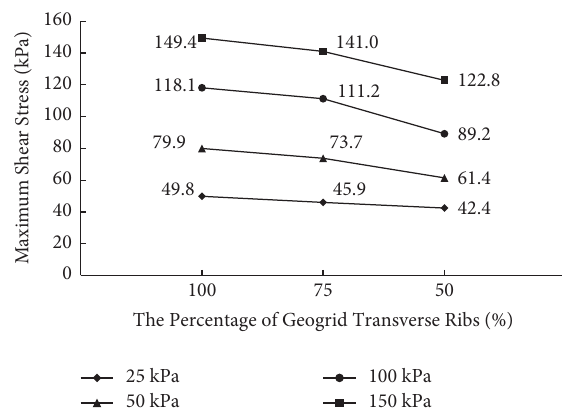
Figure 17: Variation curve of the maximum shear stress under diferent transverse rib percentages of the geogrid.